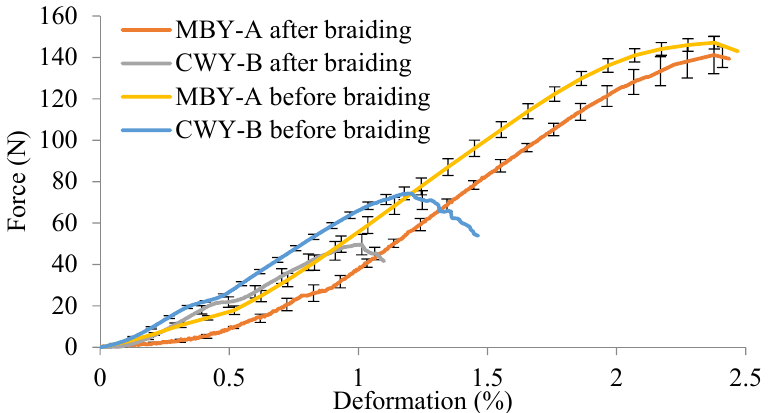
Figure 8. Force vs. deformation curves of MBY-A and CWY-B before and after braiding. Table 4. Hybrid yarn tenacities before and after the braiding process.